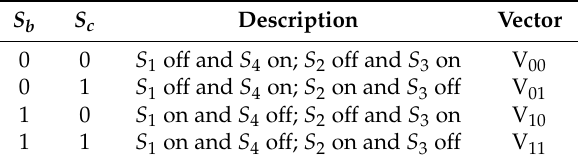
Table 1. Definition of switching states for the rotor-side converter (RSC) (Add ’ for GSC).